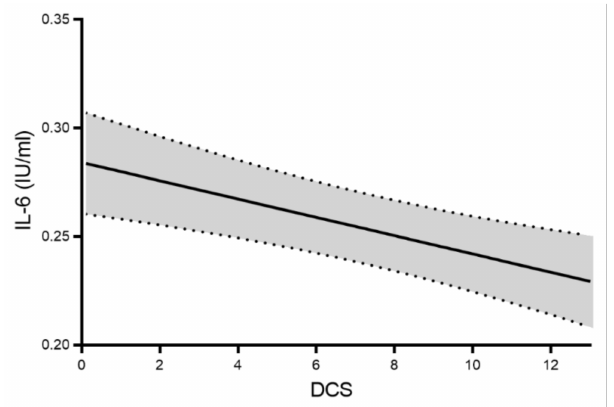
Figure 1. Linear regression analysis of the relationship between diurnal cortisol slope (DCS) and interluekin-6 (IL-6) levels (pg/mL). Higher DCS values indicate a steeper DCS. Abbreviations: Diurnal Cortisol Slope (DCS); Interleukin-6 (IL-6).